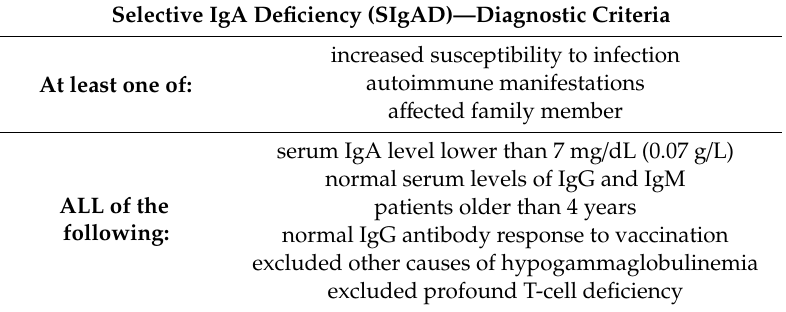
Table 1. Selective IgA deficiency (SIgAD)—diagnostic criteria according to ESID (European Society for Immunodeficiencies)